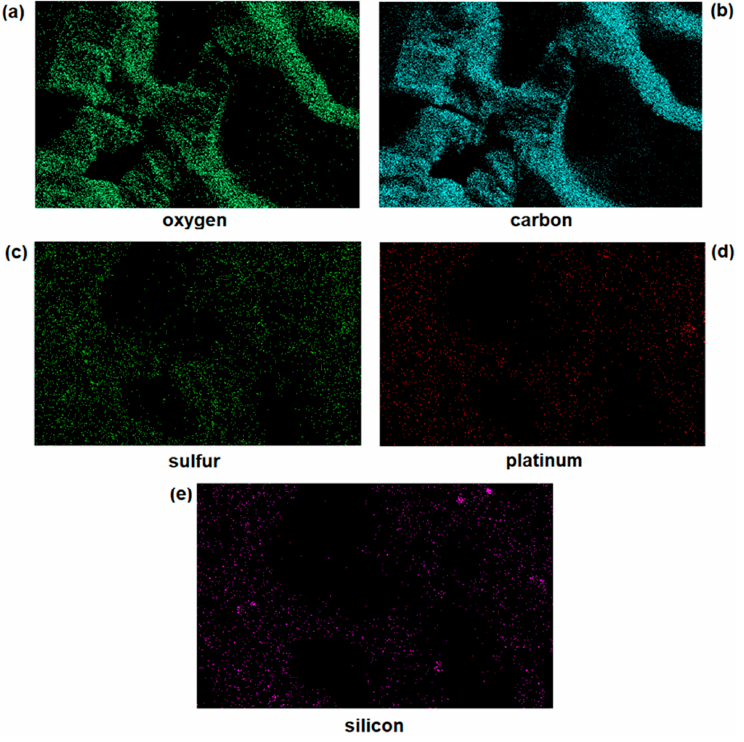
Figure 4. EDS mapping of oxygen ( a ), carbon ( b ), sulfur ( c ), platinum ( d ), and silicon ( e ) atoms of PL-HA-GSNO-SiO 2 @CisPt lyophilized hydrogel.